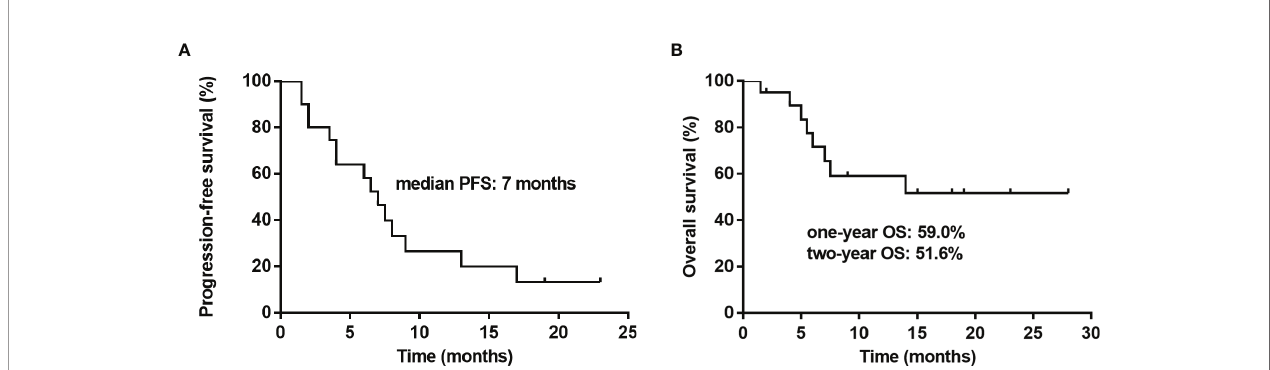
FIGURE 1 | Kaplan – Meier survival curves for twenty patients with relapsed or refractory diffuse large B cell lymphoma (R/R-DLBCL) after second-line treatment failure treated with a treatment of decitabine and a modi fi ed cisplatin, cytarabine, and dexamethasone (DHAP) regimen. (A) Progression-free survival (PFS) is shown for twenty patients, showing that the median PFS is 7 months. (B) Overall survival (OS) is shown for twenty patients, showing that the one-year OS is 59.0% and two-year OS is 51.6%.